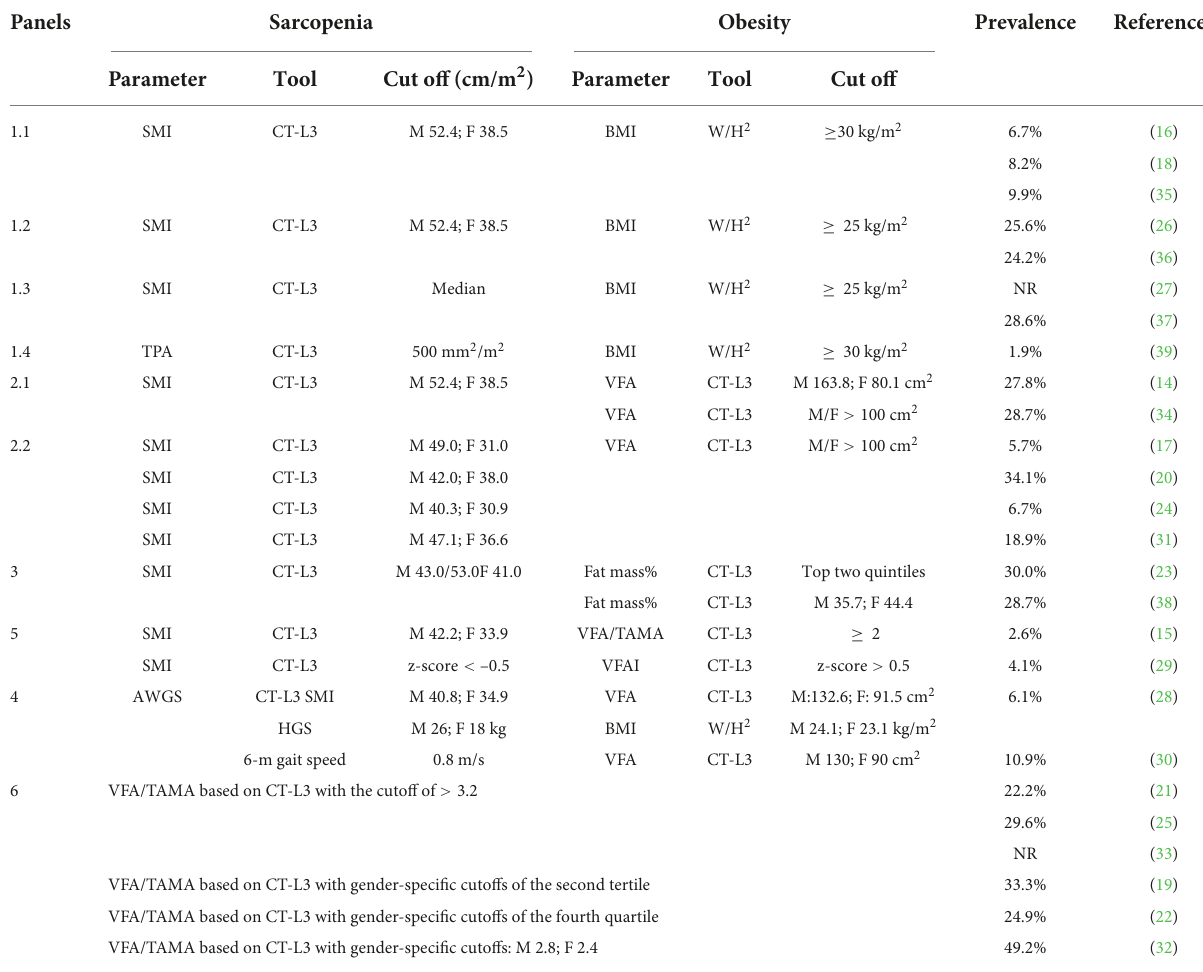
TABLE 2 Panels of sarcopenic obesity definitions, criteria, and prevalence. Panels